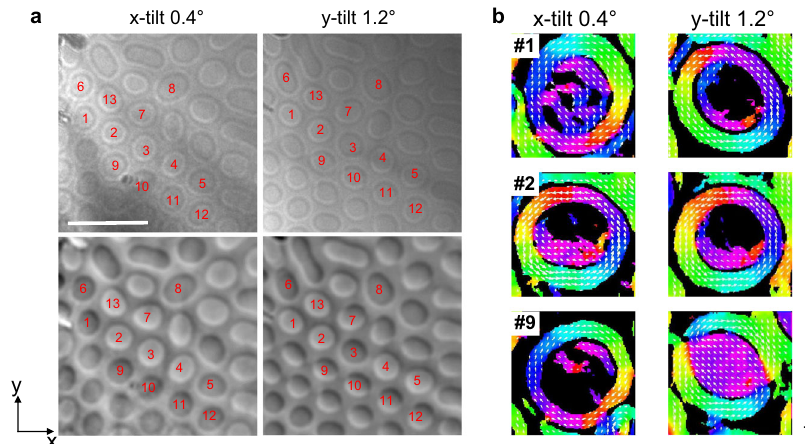
Fig. 2 | Real-space observation of fi eld-free room temperature skyrmion bub- bles after FCmanipulation. a The 300 μ m overfocused images( fi rst row)and TIE retrieved phase images (second row) with an x-tilt of 0.4° and a y-tilt of 1.2°, respectively.The scale baris500nm. b The con fi guration of the in-planemagnetic